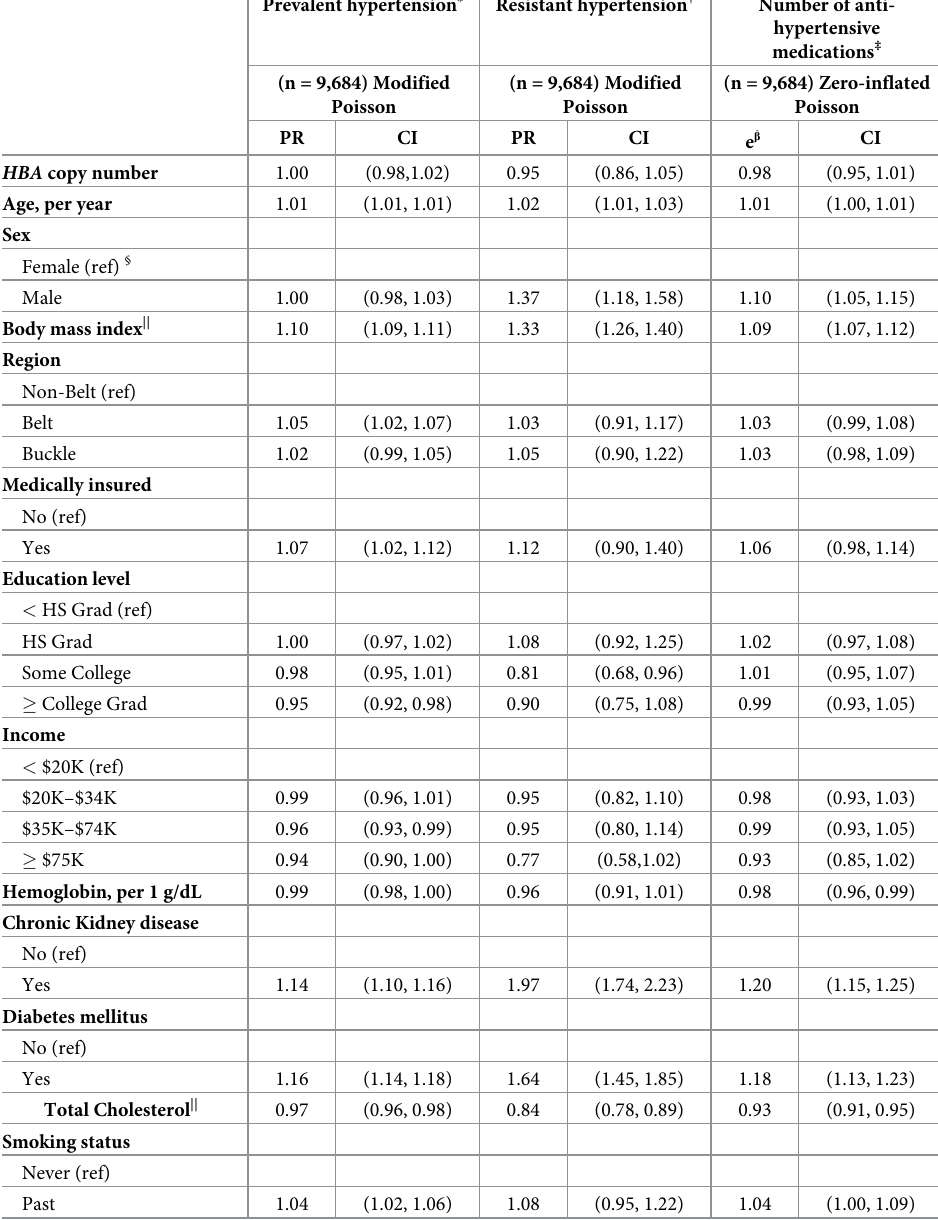
Table 2. Association of HBA copy number with prevalent hypertension, resistant hypertension, or anti-hyperten- sive use–fully adjusted